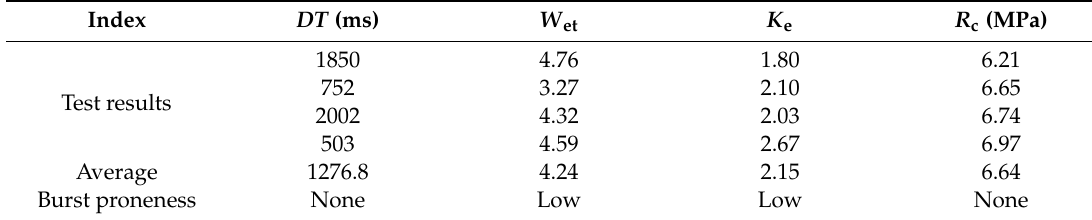
Table 5. Test result and coal burst proneness of PJ coal mine.